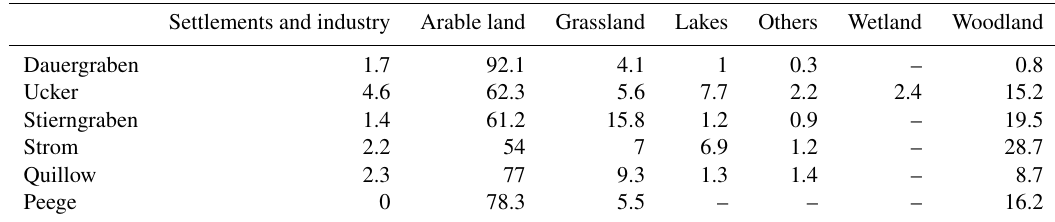
Figure 1. Map of the study area. Coordinates of WGS84 / UTM zone 33N are given inm. (a) Stream water monitoring sites and the location of the study area (upper Ucker river catchment) within Germany. (b) Section with the included groundwater monitoring sites. For better readability only the number of the ID of the monitoring sites is shown. Table 1. Share of land use classes in the different catchments (percent of land cover) based on CORINE Land Cover 2000 data (DLR-DFD and UBA,